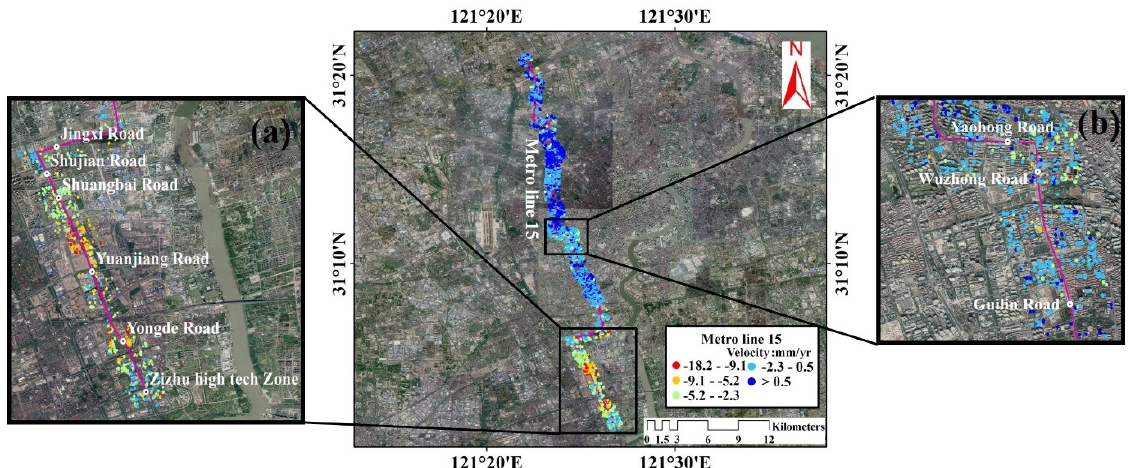
Figure 11. Subsidence rate map of metro line 15 and its surrounding area. Area A and Area B are shown in ( a ) and ( b ) respectively.